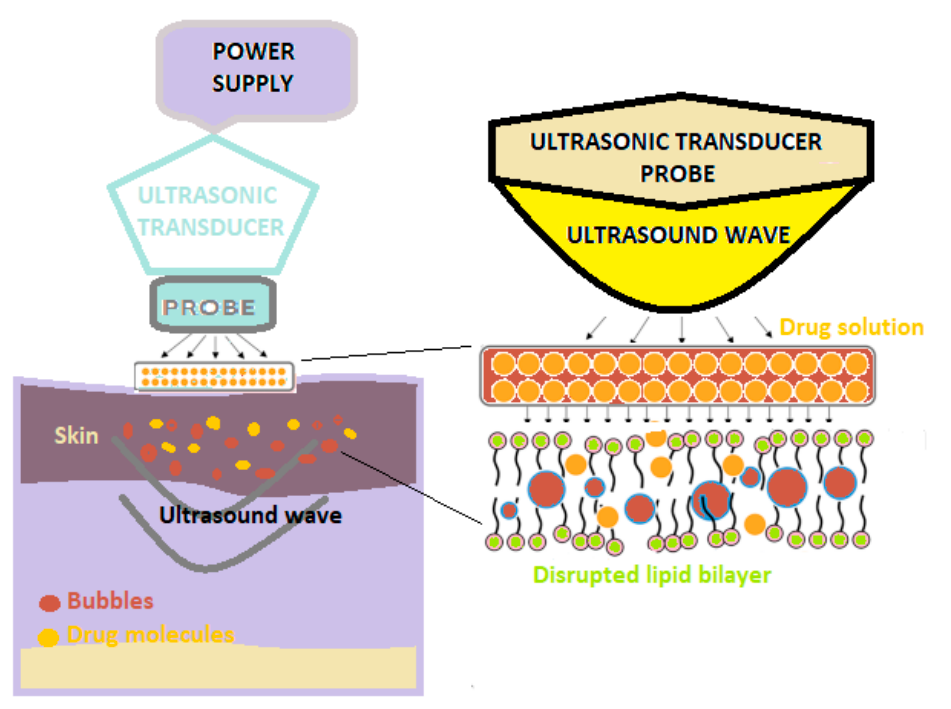
Figure 3. A schematic illustration of sonophoresis-assisted transdermal drug delivery [30].